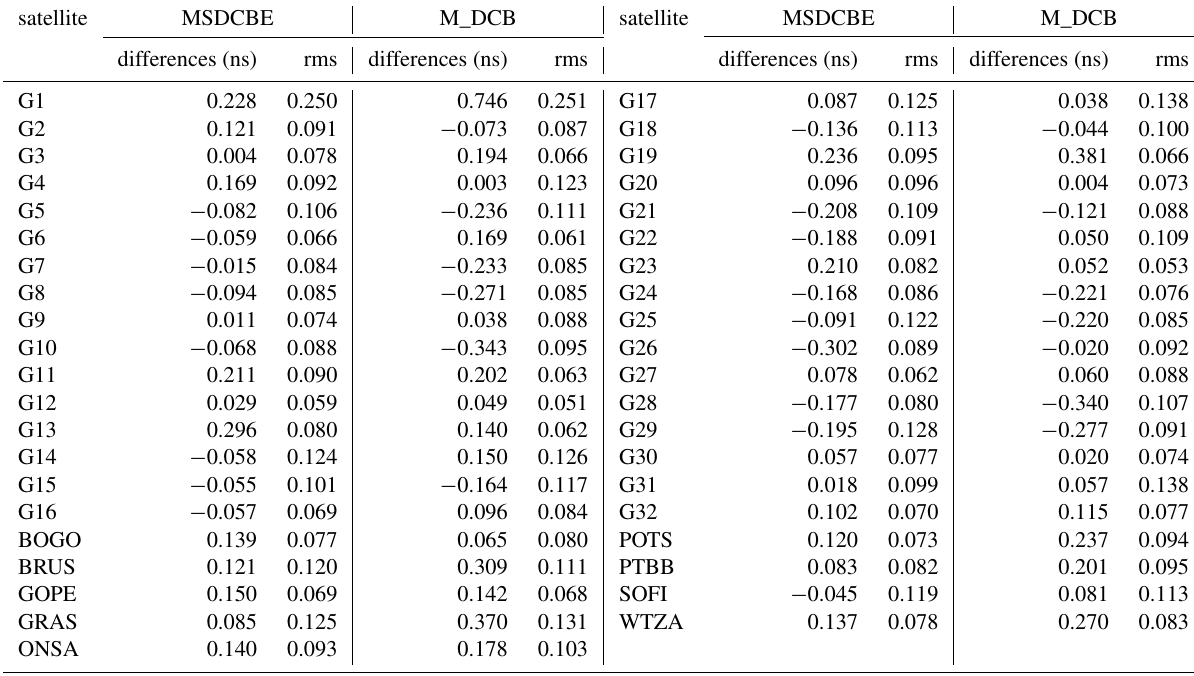
Table 1. The differences and rms between satellites and receivers estimated from 1 to 31 January 2010 using multiple GPS stations (MSDCBE and M_DCB minus CODE).